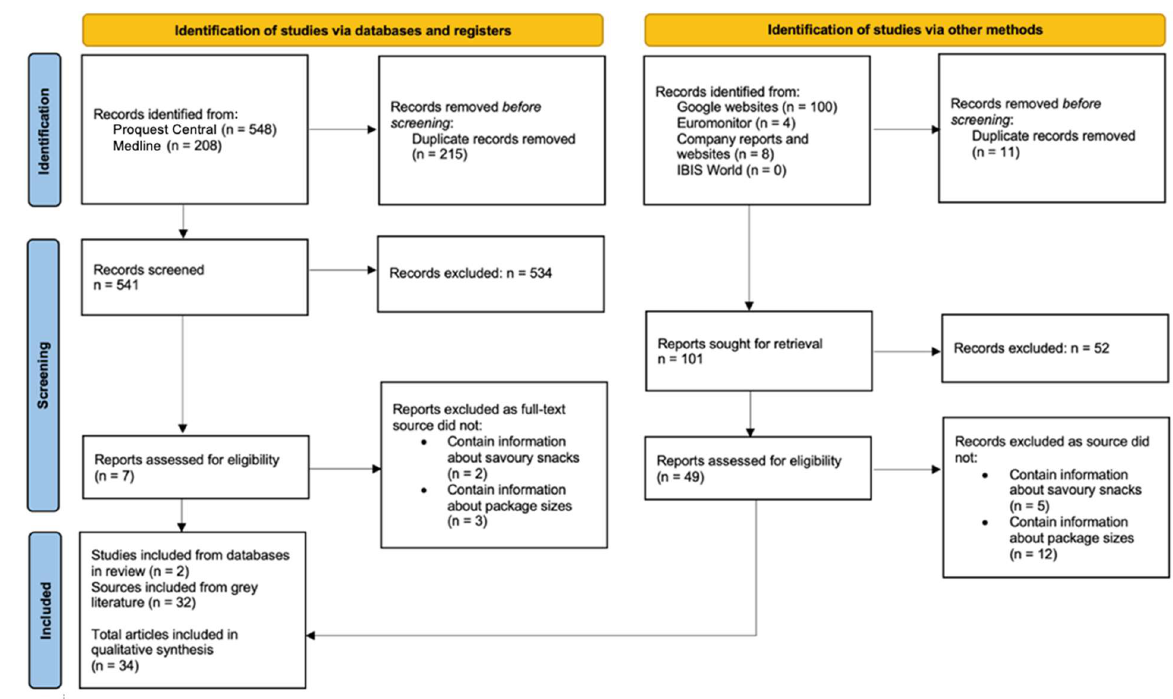
Figure 3 . PRISMA flow chart of studies and other literature sources on savoury snacks included in the scoping review . Table 2. Industry reasons for changes in savoury snack package